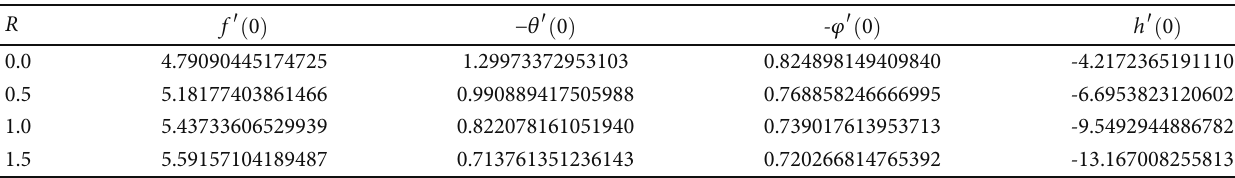
Table 3: Values of skin friction coe ffi cient, heat transfer and mass transfer for radiation parameter variation with γ = 45 ° , M = 2 , c = 0 : 5 , Pr = 0 : 71